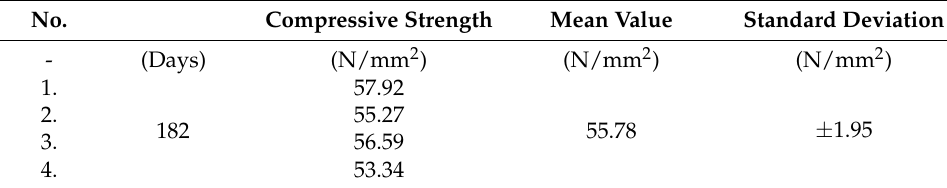
Figure 1. Test specimens; location of the connectors in the walls. Table 1. Concrete compressive strength tests.